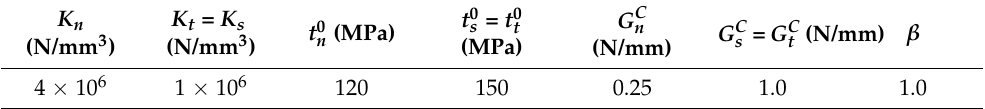
Table 5 listed the interfacial parameters for the model. Table 5. Interfacial parameters for cohesive layers [32]. Table 5. Interfacial parameters for cohesive layers [32].